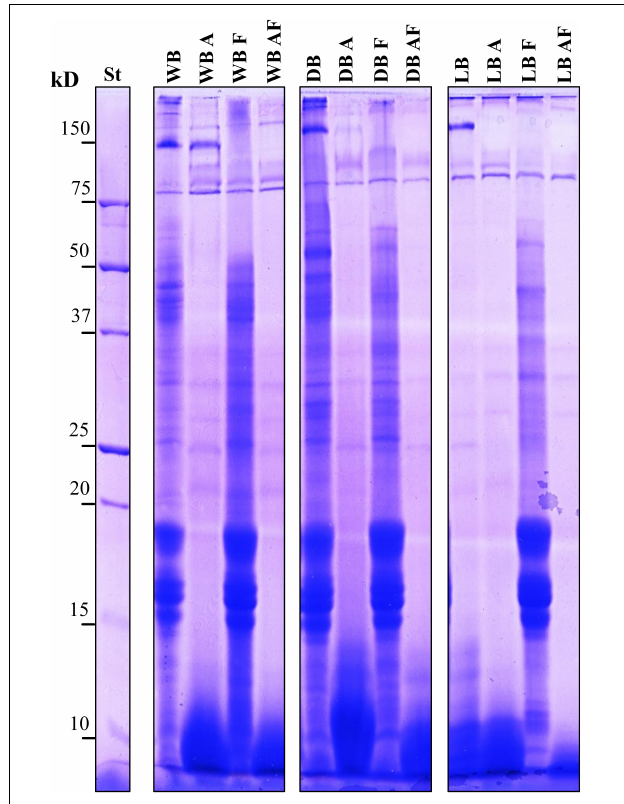
FIGURE 2 | Sodium dodecyl sulfate–polyacrylamide gel electrophoresis (SDS-PAGE) patterns of total proteins of wet (WB), dried at low temperature (DB), and lyophilized (LB) Spirulina biomass. All biomasses were also treated with Alcalase R (cid:13) (A, 1% vol/wt), fermented with L. plantarum T0A10 (F, final cell density of circa 7 log10 cfu/g), or fermented and treated with Alcalase R (cid:13) (AF). Enzymatic and microbial treatments were carried out at 30 ◦ C for 24 h. St, protein standard (Bio-Rad, Hercules, CA, United